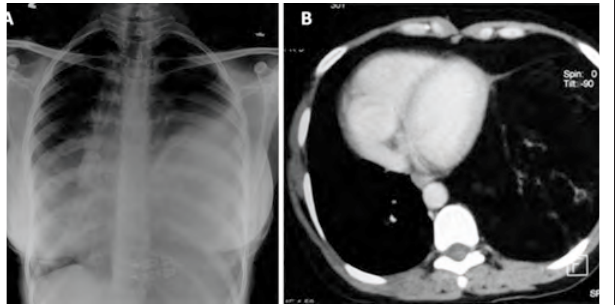
Fig. 7. (A) Chest skiagram reveals non-homogeneous opacities in bilateral mid and lower zones predominantly in central regions silhouetting the cardiac borders with blunting of bilateral costophrenic and cardiophrenic angles. (B) Axial CT image of the same patient showing a well-marginated fat attenuation mass with thin strands of fibrous septa on both sides of the hemithorax.